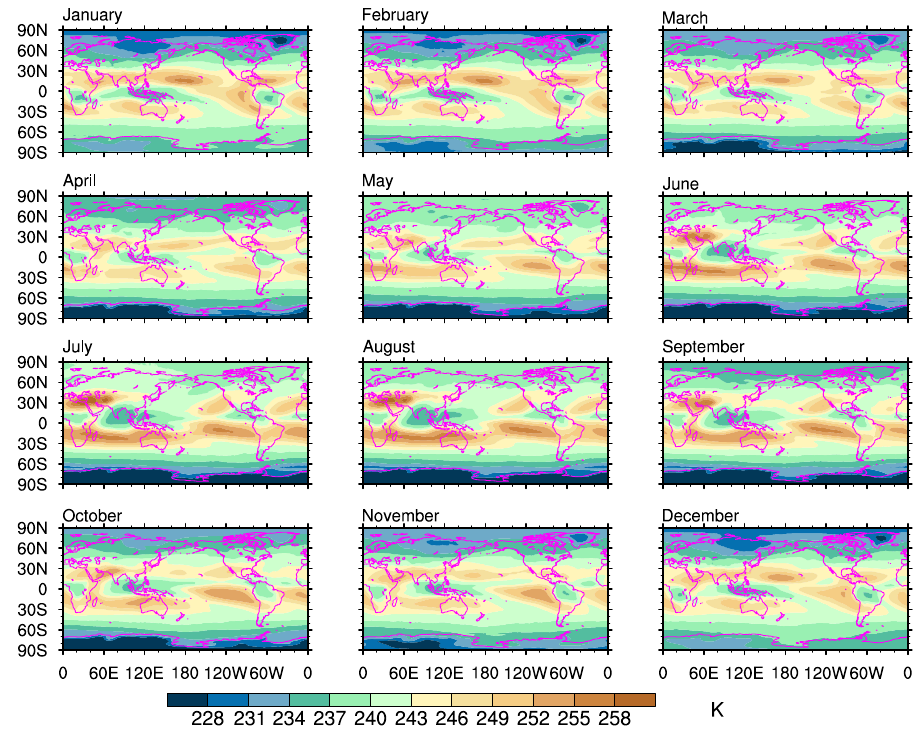
Fig. 4. Monthly climatology of HIRS channel 12 T B based on data from